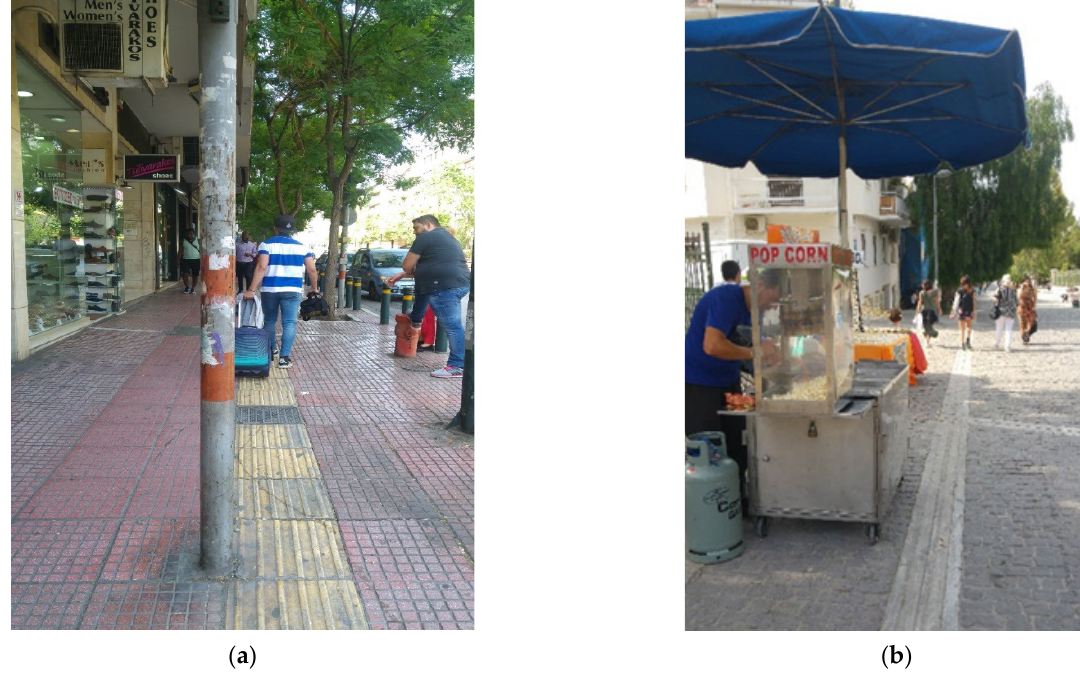
Figure 8. ( a ) Example of small width obstacle; ( b ) Example of medium width obstacle.